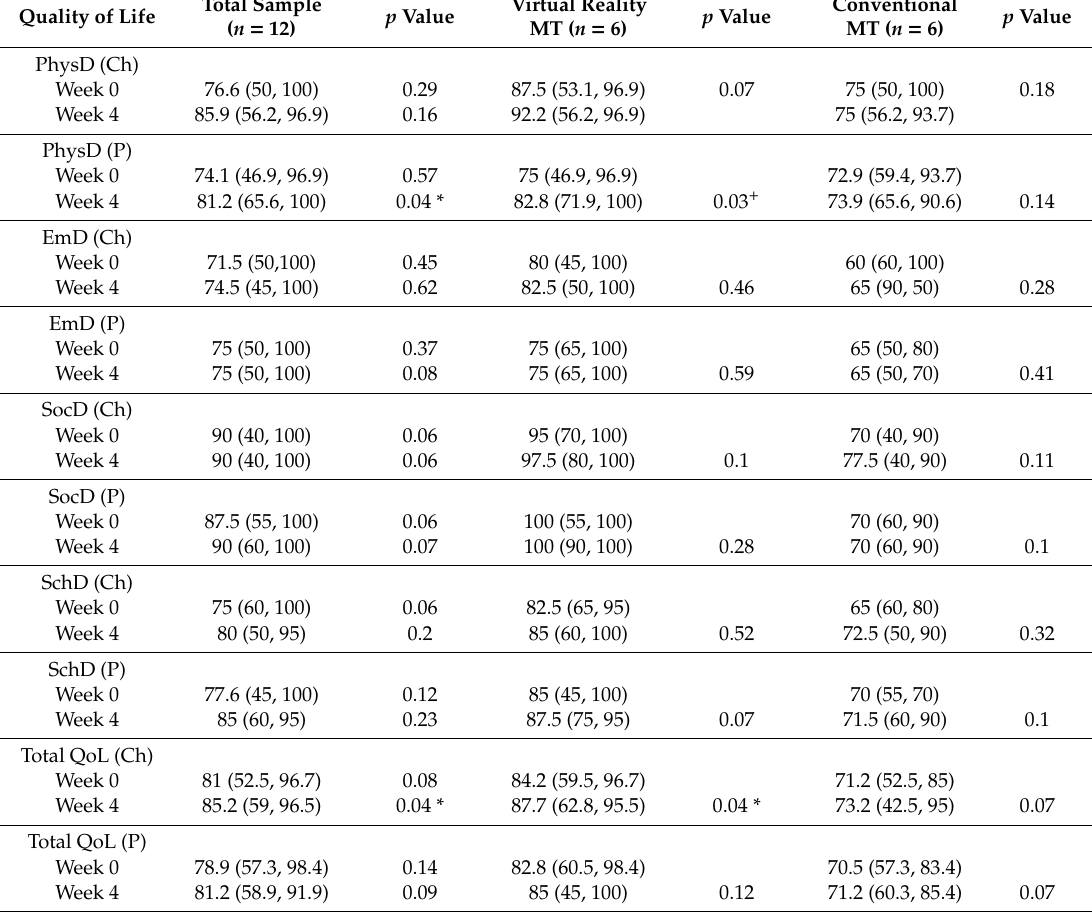
Table 6. Results of quality of life for Conventional MT and Virtual Reality